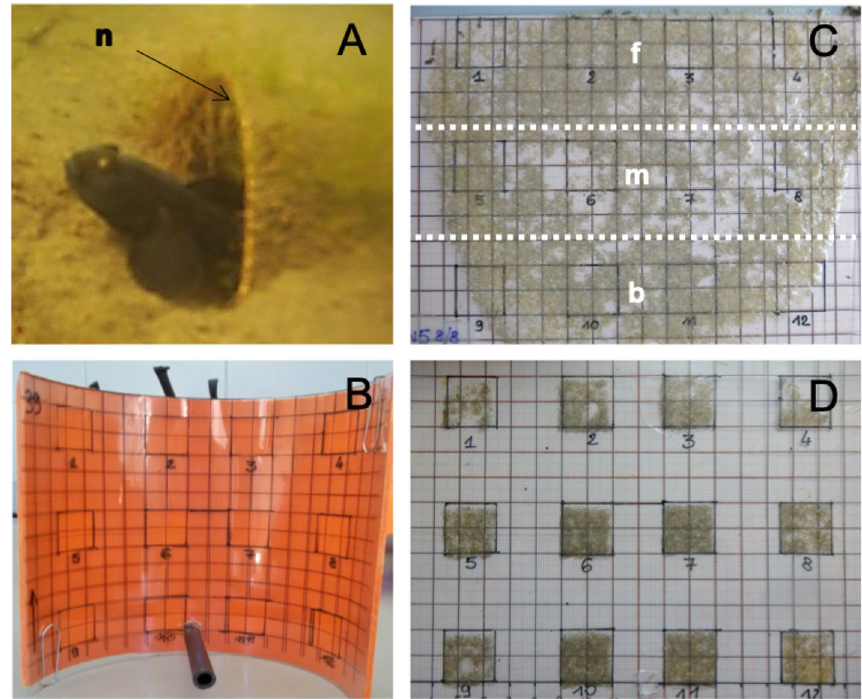
Figure 1. Black goby artificial nest and egg sampling. ( A ) Territorial male inside an artificial nest (n); ( B ) acetate sheet with printed grid fixed on the nest ceiling; ( C ) acetate sheet, with embryos, divided in three equal sized sub-areas from the main to the secondary nest access: (f) front, (m) middle and (b) back; ( D ) acetate sheet sub-areas (1 to 12) were isolated to randomly collect eight embryos from each one.